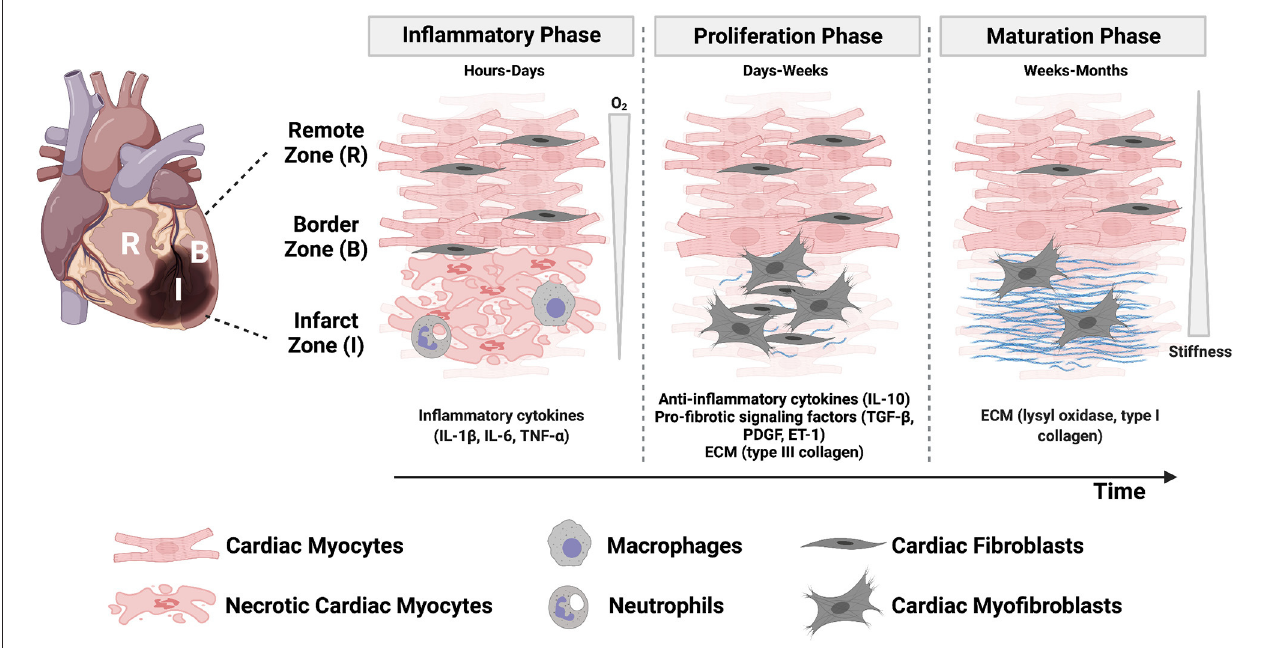
FIGURE 1 | The post-infarct microenvironment is characterized by dynamic physical, mechanical, and biochemical cues that orchestrate the three phases of healing. Regional and temporal changes of oxygen concentration, stiffness, inflammatory cytokines, cell, and matrix composition characterize the myocardium as injured tissue is replaced with a scar. Created with